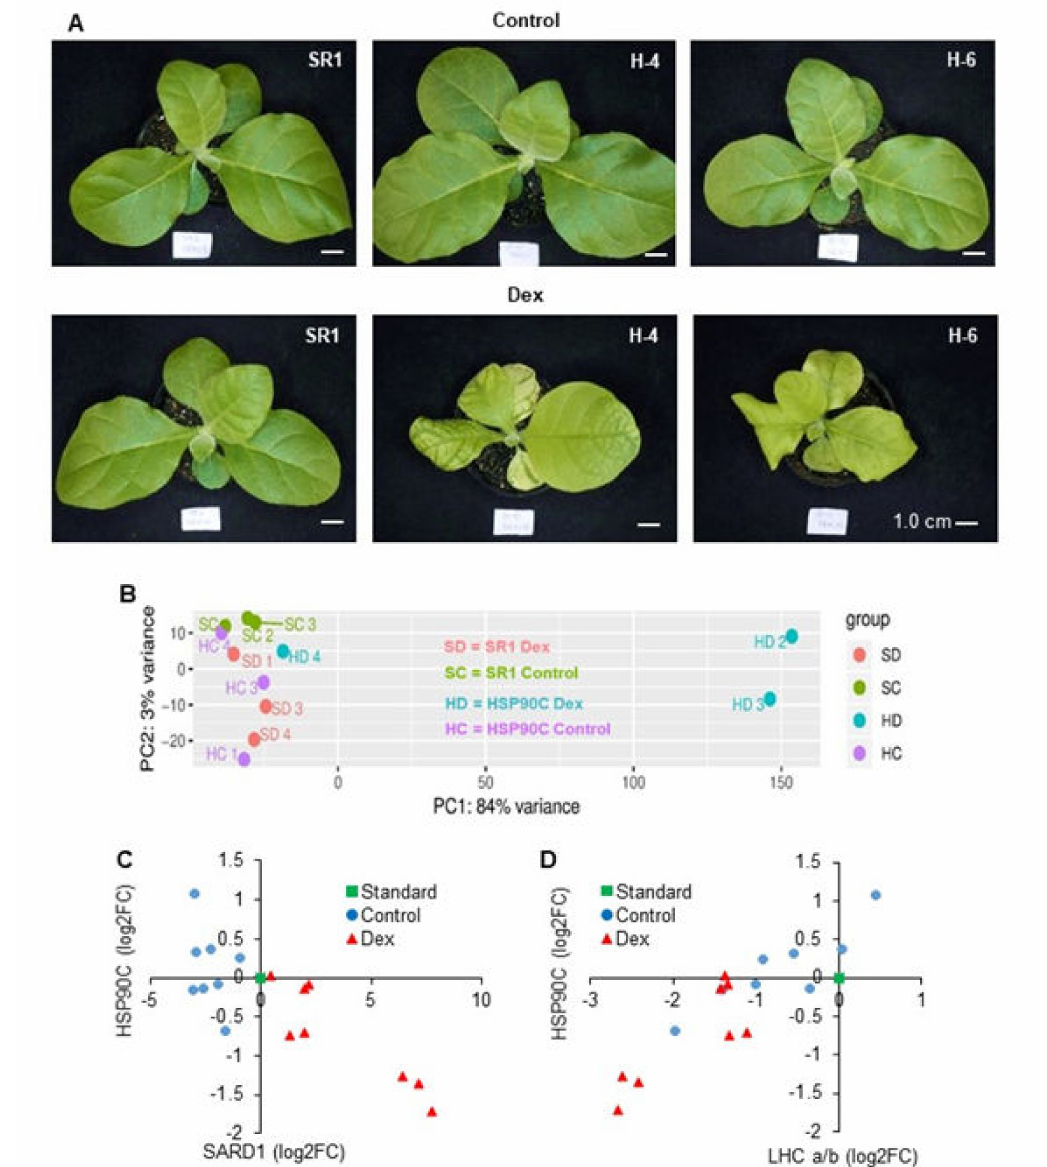
Figure 1. Phenotype and transcriptome change after induced silencing of HPS90 in transgenic tobacco plants. ( A ) Non-transformed SR1 (SR1), i-hpHSP90C 4–5 (H-4), and i-hpHSP90C 6-1 (H-6) plants were grown for three weeks, sprayed with 0.01% Tween-20 containing 0.5% ethanol (Control) or 50 µ M Dex (Dex), and photographed at 7 days post-treatment (dpt). Scale bars indicate 1 cm. ( B ) Principle component analysis of RNA-seq data. RNA preparations from 1-dpt control-treated SR1 (SC2, 3, and 4), Dex-treated SR1 (SD1, 3, and 4), control-treated i-hpHSP90C-4 (HC1, 3, and 4), and Dex-treated i-hpHSP90C-4 (HD2, 3, and 4) were analyzed for the di ff erential gene expression by using the DESeq2 package in Galaxy platform. ( C , D ) Variation of HSP90C silencing in individual Dex-treated i-hpHSP90C-4 plants. Expression levels of SARD1 ( C ) and LHC a / b ( D ), representatives of up- and downregulated genes found in the RNA-seq analysis, respectively, were plotted with those of HSP90C. The expression levels of these genes relative to a fixed standard sample (square) were quantified in eight individual plants from each of the control- (circles) and Dex-treated (triangles) i-hpHSP90C-4 plant